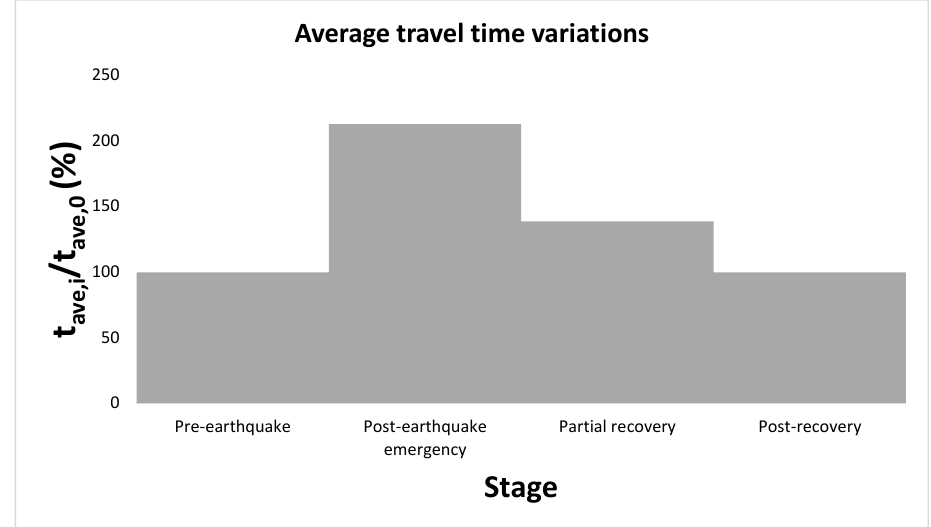
Figure 6. Time delay ratios during the different recovery stages.